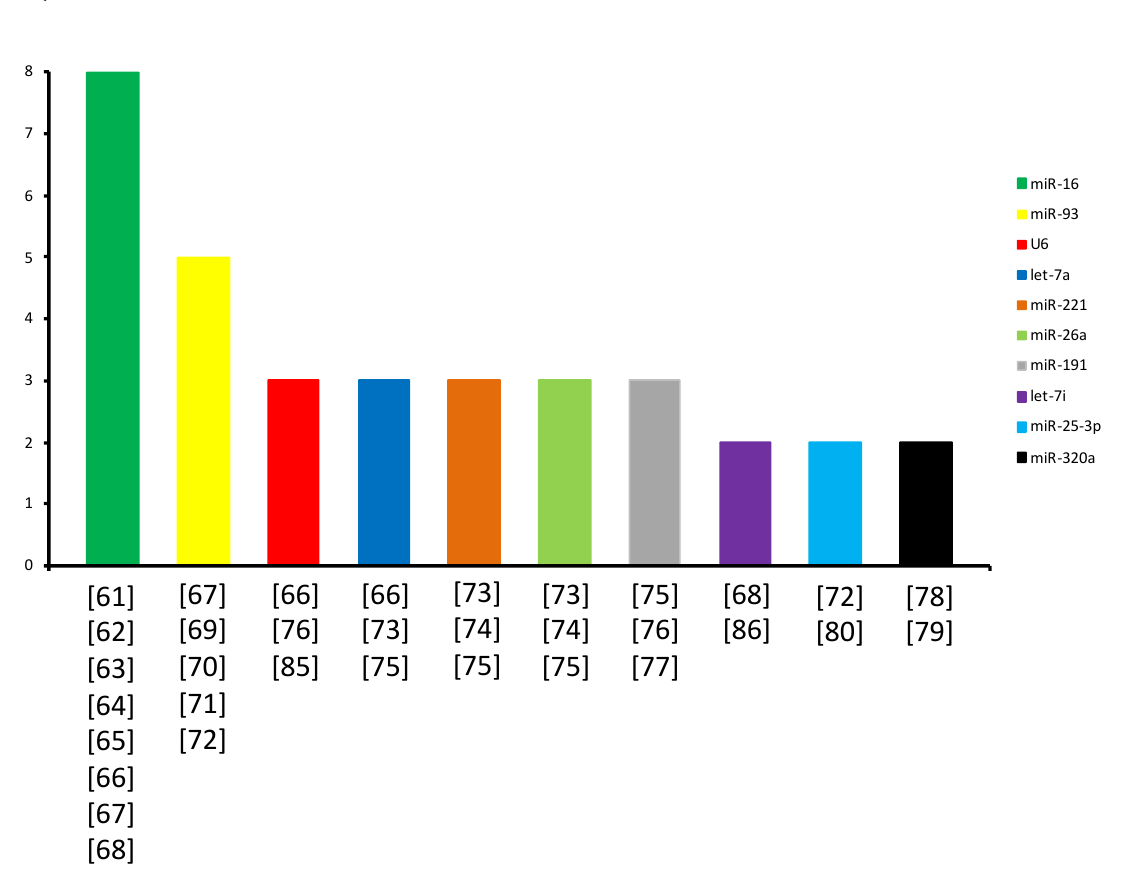
Figure 1. RGs literature distribution. The figure shows the RGs ranked according to their usage frequency in literature. miRNAs with frequency = 1 are not shown.